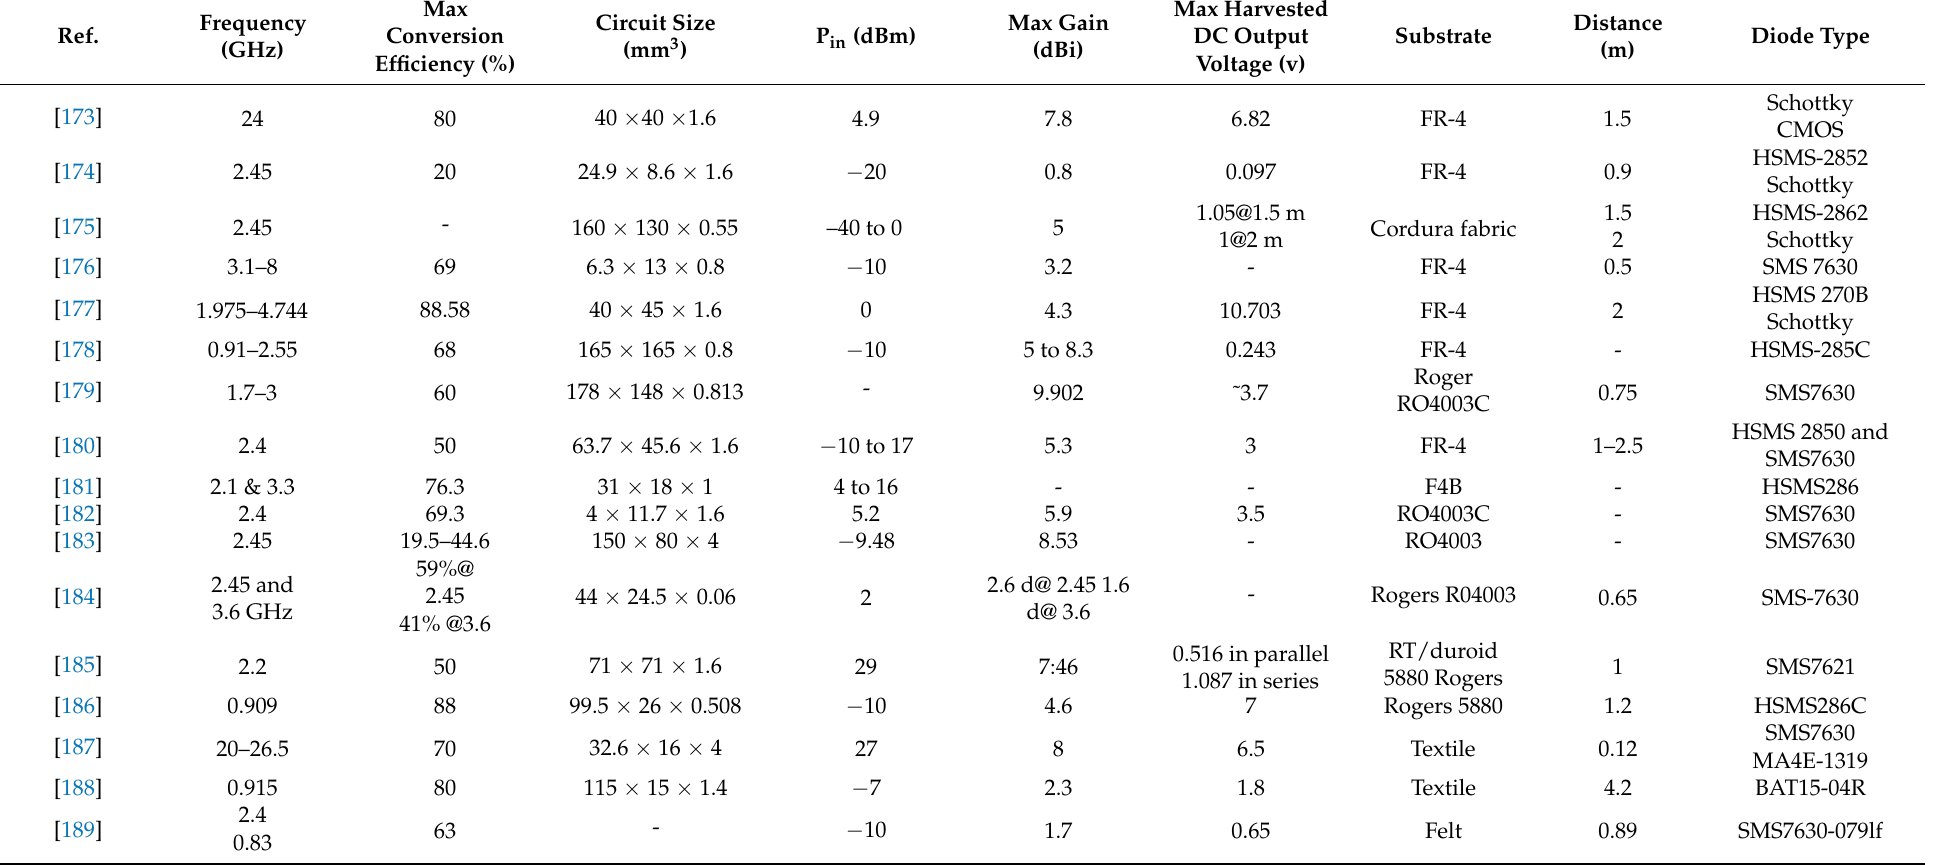
Table 2. The comparative study on the variation of existing circuits for the RF-EH approach.